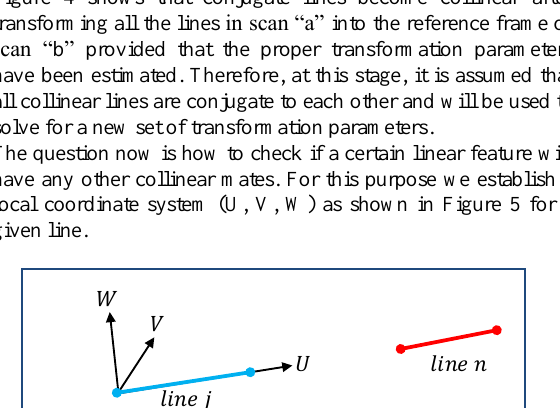
process for two simulated scans as seen in Figure 7.